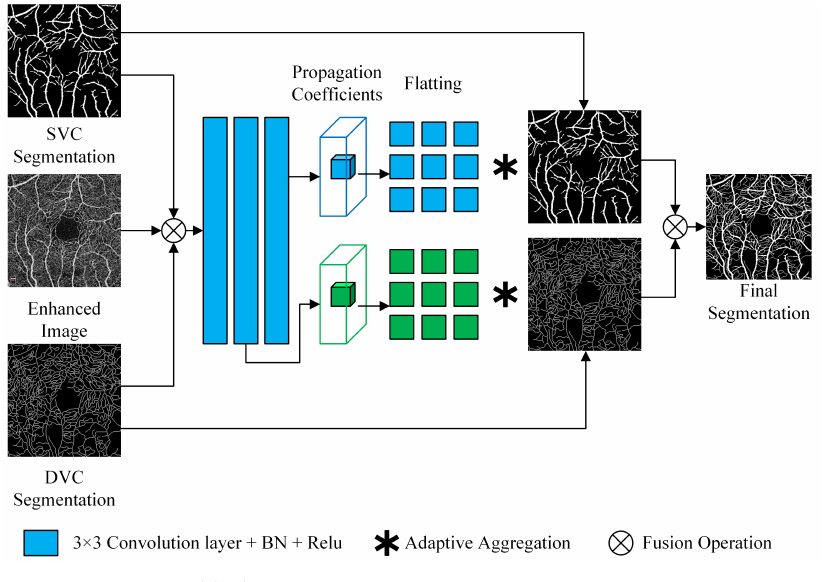
Figure 4. Fine-tune